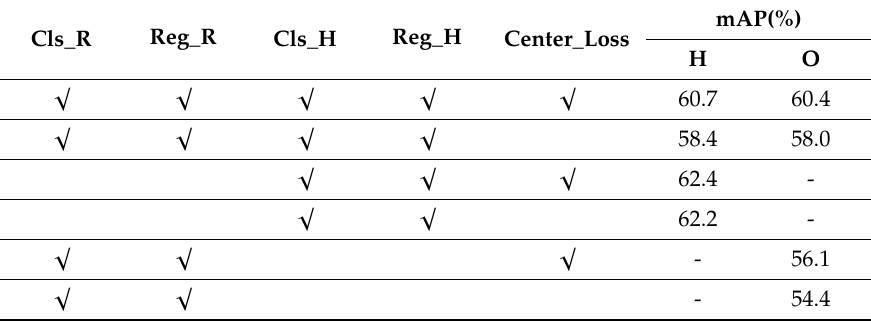
Table 10. Ablation Experimental Results of Multi-task